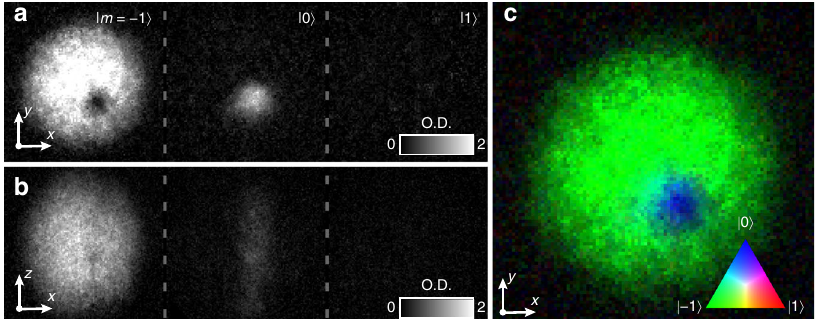
Fig. 5 A singly quantised, singular SO(3) vortex in three dimensions. a , b Experimental absorption images of the atomic density in each spinor component from the top ( a ) and side ( b ), expressed in terms of dimensionless optical depth (O.D.), for the SO(3) vortex con fi guration after one of the two vortices has exited the system. The m = − 1 component displays a vortex line, the core of which is fi lled with m = 0 atoms. The system has evolved for 1000ms after imprinting. c Composite false colour image of the condensate density as viewed from the top. The fi eld of view of each image is 219 μ m × 219 μ m. Source data are provided as a Source Data fi le